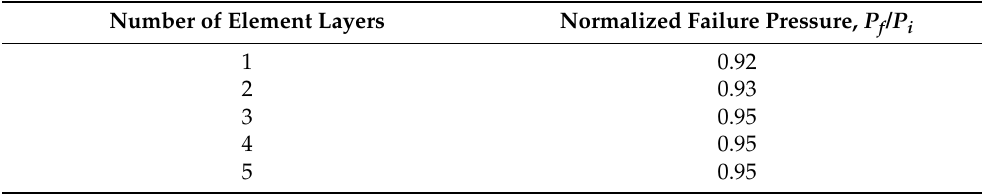
Table 2. Convergence test results for the optimum number of mesh layers at the defect region.